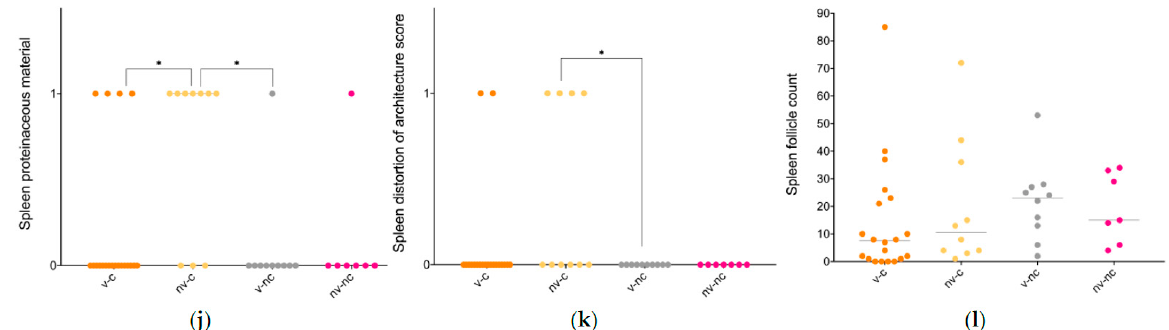
Figure A1. ( a ) the lung necrosis score, whilst ( b – d ) presents the inflammation, oedema, and congestion score of the lung, respectively. ( e – h ) displays the air sac necrosis, inflammation, oedema, and congestion score, respectively. ( i ) presents the spleen necrosis score, ( j ) the proteinaceous fluid score, ( k ) the tissual architecture distortion score and ( l ) the follicle count obtained from each section. Statistical analyses were performed using a Kruskal-Wallis test and Dunn’s multiple comparison test. * p < 0.05, ** p < 0.01, *** p < 0.001. Abbreviations: nv-c, not vaccinated-challenged; nv-nc, not vaccinated-not challenged; v-nc, vaccinated-not challenged; v-c, vaccinated-challenged.